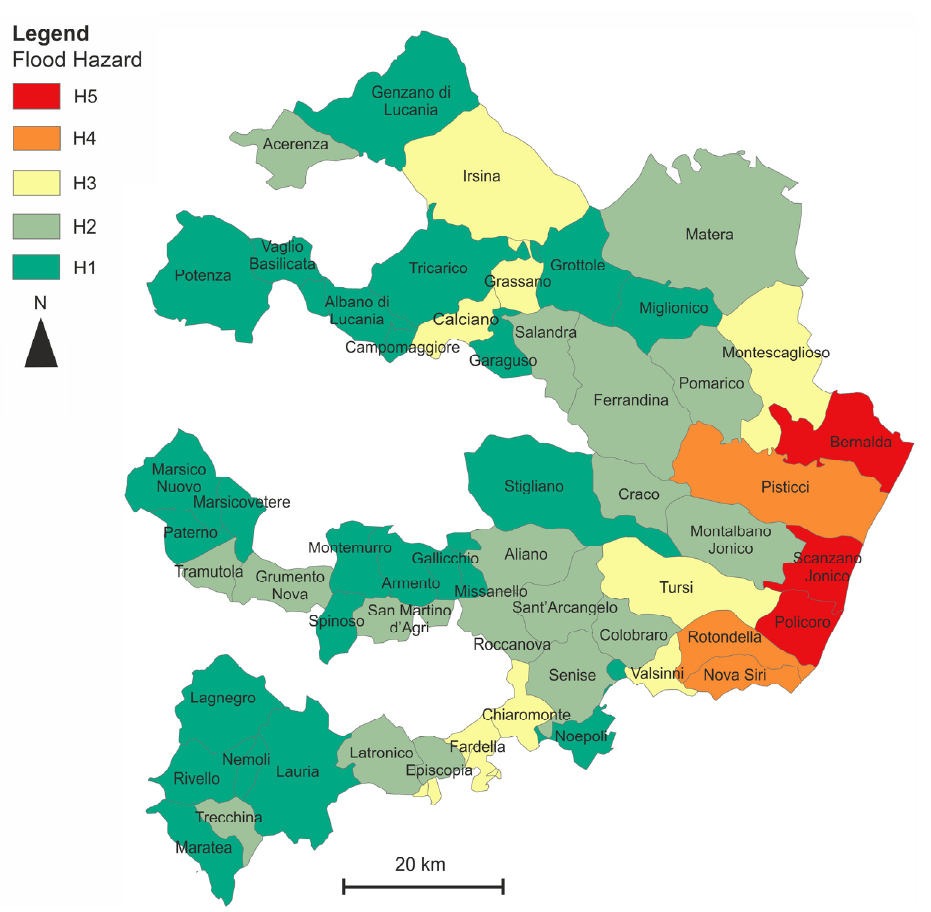
Figure 5. Classification of the municipalities based on the maximum percentage of municipal territory occupied by areas prone to be flooded in case of low hazard scenario (return period = 500 years).